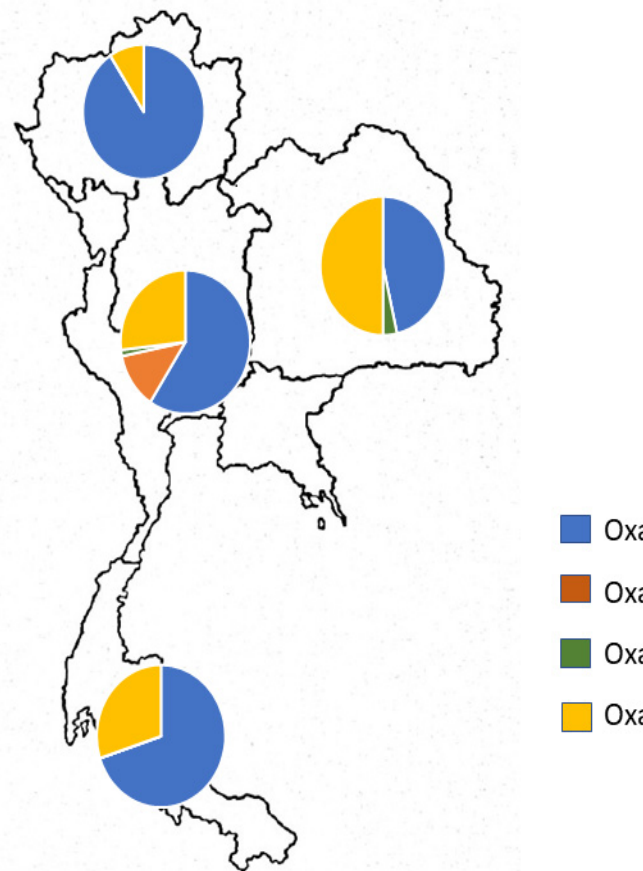
Figure 2. Geographical distribution of oxacillinase (OXA)-type carbapenemase-encoding genes present in carbapenem-resistant A. baumannii isolates from across Thailand.